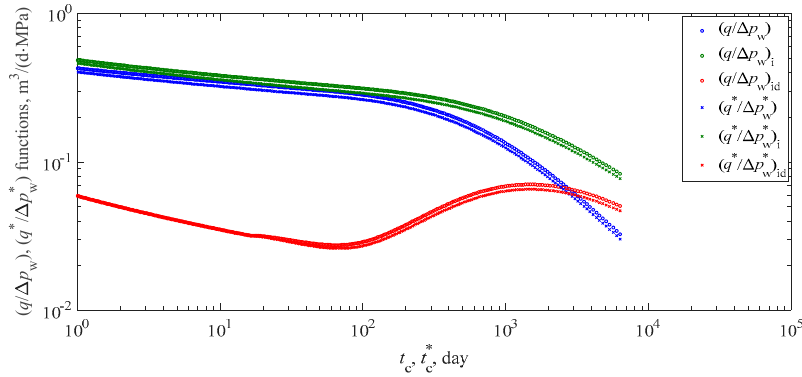
Figure 20. Normalized rate functions and modified normalized rate functions for Case 1.